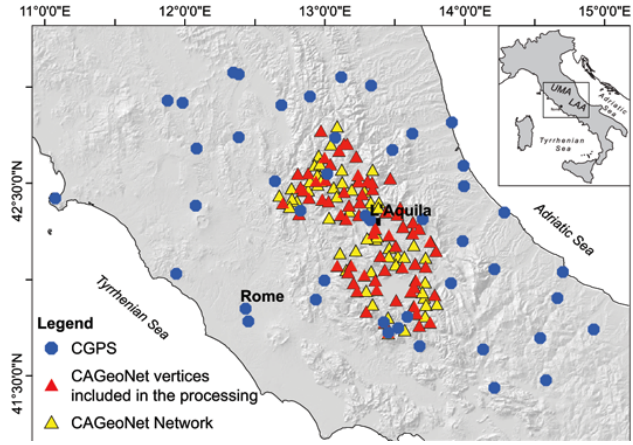
Figure 2. The Central Apennines Geodetic Network (CAGeoNet, triangles) and continuous GPS stations (blue dots) used in the analysis. Inset: Location of the study region within Italy. UMA, Umbria-Marche Apennines; LAA, Lazio-Abruzzo Apennines.